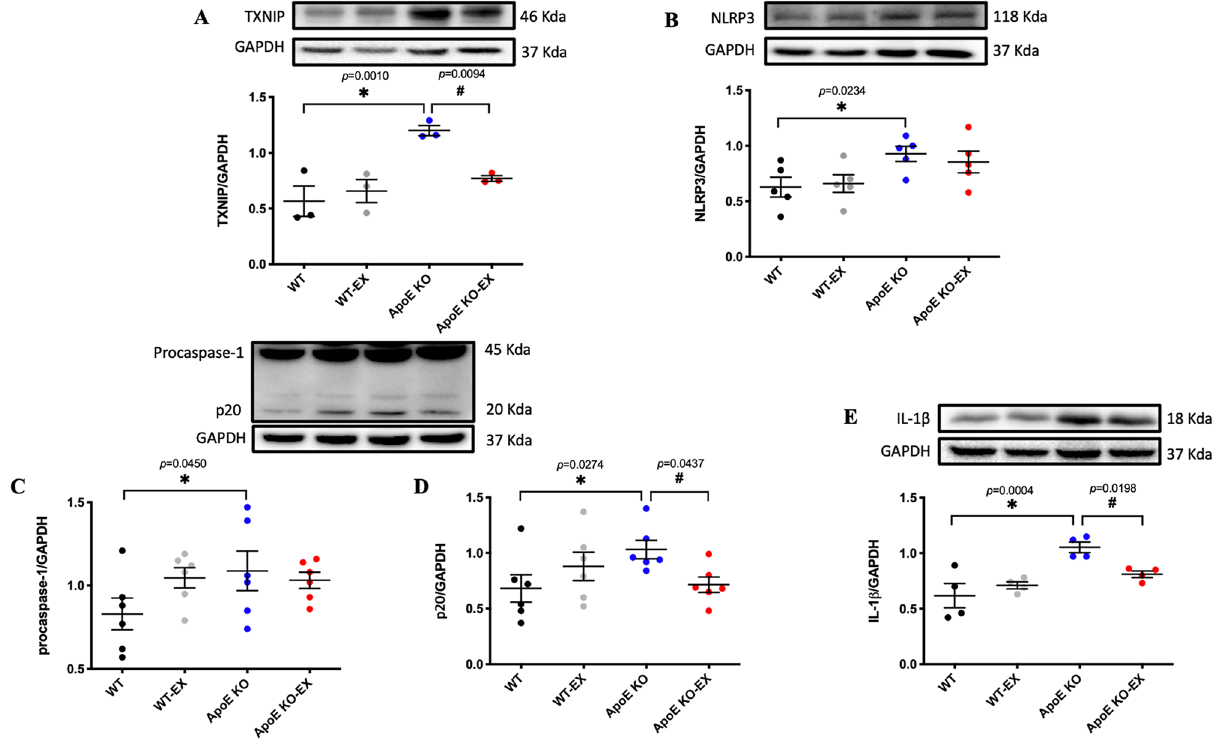
Figure 3. Effect of exercise training on TXNIP/NLRP3 inflammasome in the heart of ApoE KO mice. ( A – E ): The protein expression of TXNIP ( A ; n = 3/groups), NLRP3 ( B ; n = 5/groups), pro-caspase-1 ( C ; n = 6/groups), caspase-1 p20 ( D ; n = 6/groups), and IL-1β ( E ; n = 4/groups) were measured by immunoblot analysis from each group. Bar graph values are presented as means ± SEM. * p < 0.05 versus WT, # p < 0.05 versus ApoE